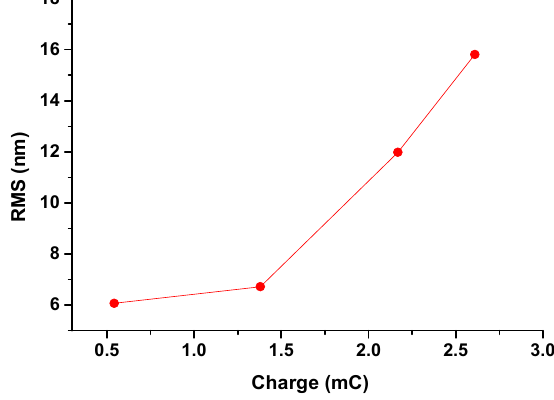
Figure 10. RMS dependence on electropolymerization charge.